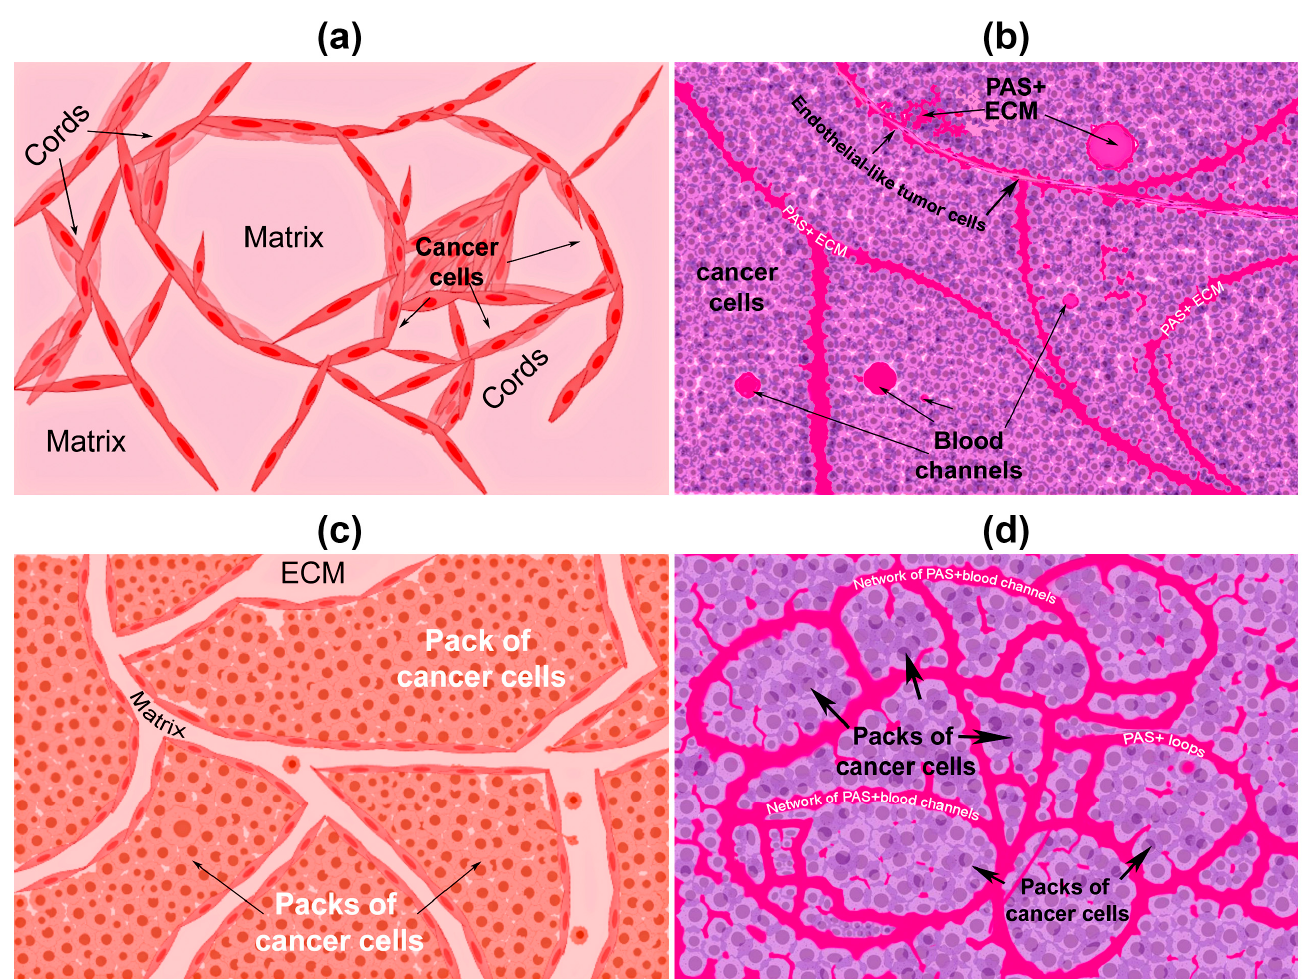
Figure 1. Graphical representation of the types of vasculogenic mimicry structures formed in vitro and in vivo by cancer cells. ( a ) In vitro tubular type. Is formed by networks of cellular cords encircling cell-free spaces above a matrix rich in collagen such as Matrigel. Tumor cells aligned in cords or tubular-like interconnected structures are depicted. ( b ) In vivo tubular type (parallel PAS+ patterned). Deposits of PAS+ proteoglycan/laminin-enriched matrix derived from cancer cells resembling “matrix rivers” may contain PAS+ tumor cells able to form channels and may be flanked by endothelial-like tumor cells. ( c ) In vitro patterned matrix type. Flattened tumor cells lodged into the matrix form packages of cells that deposit matrix enriched in collagen, laminin, and proteoglycans. Tumor endothelial-like cells may be found surrounding the packs. ( d ) In vivo patterned matrix type (network or back-to-back loops PAS+ patterned). Several layers of extracellular matrix rich in laminin, fibronectin, and collagens IV and VI form loops surrounding packs of tumor cells.